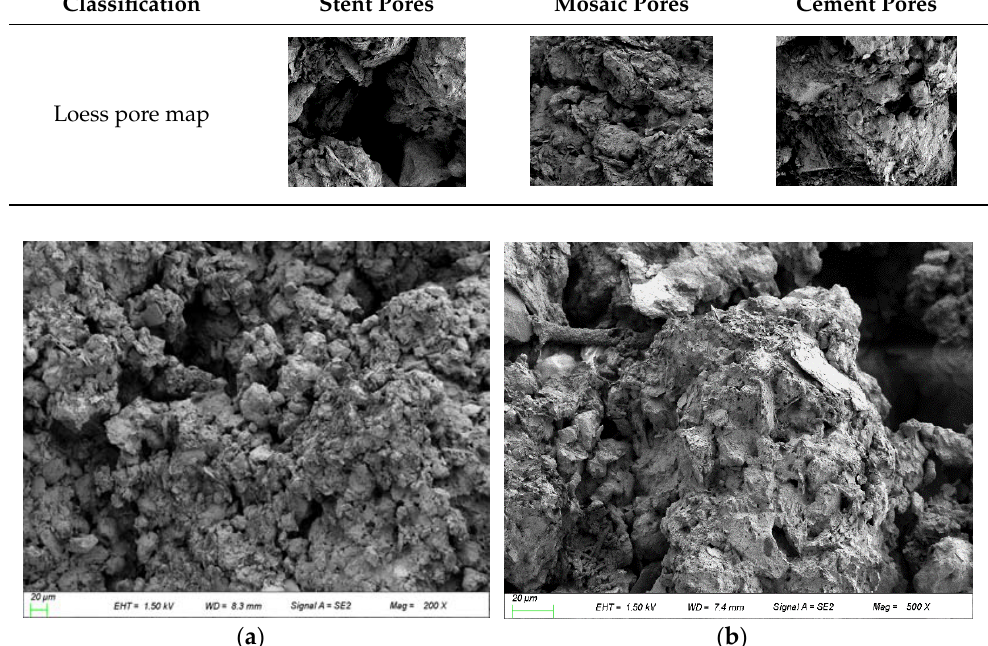
Figure 5. Pore microstructure of loess before MICP curing. ( a ) Loess structure before solidification under 200 times; ( b ) Loess structure before solidification under 500 times. under 200 times; ( b ) Loess structure before solidification under 500